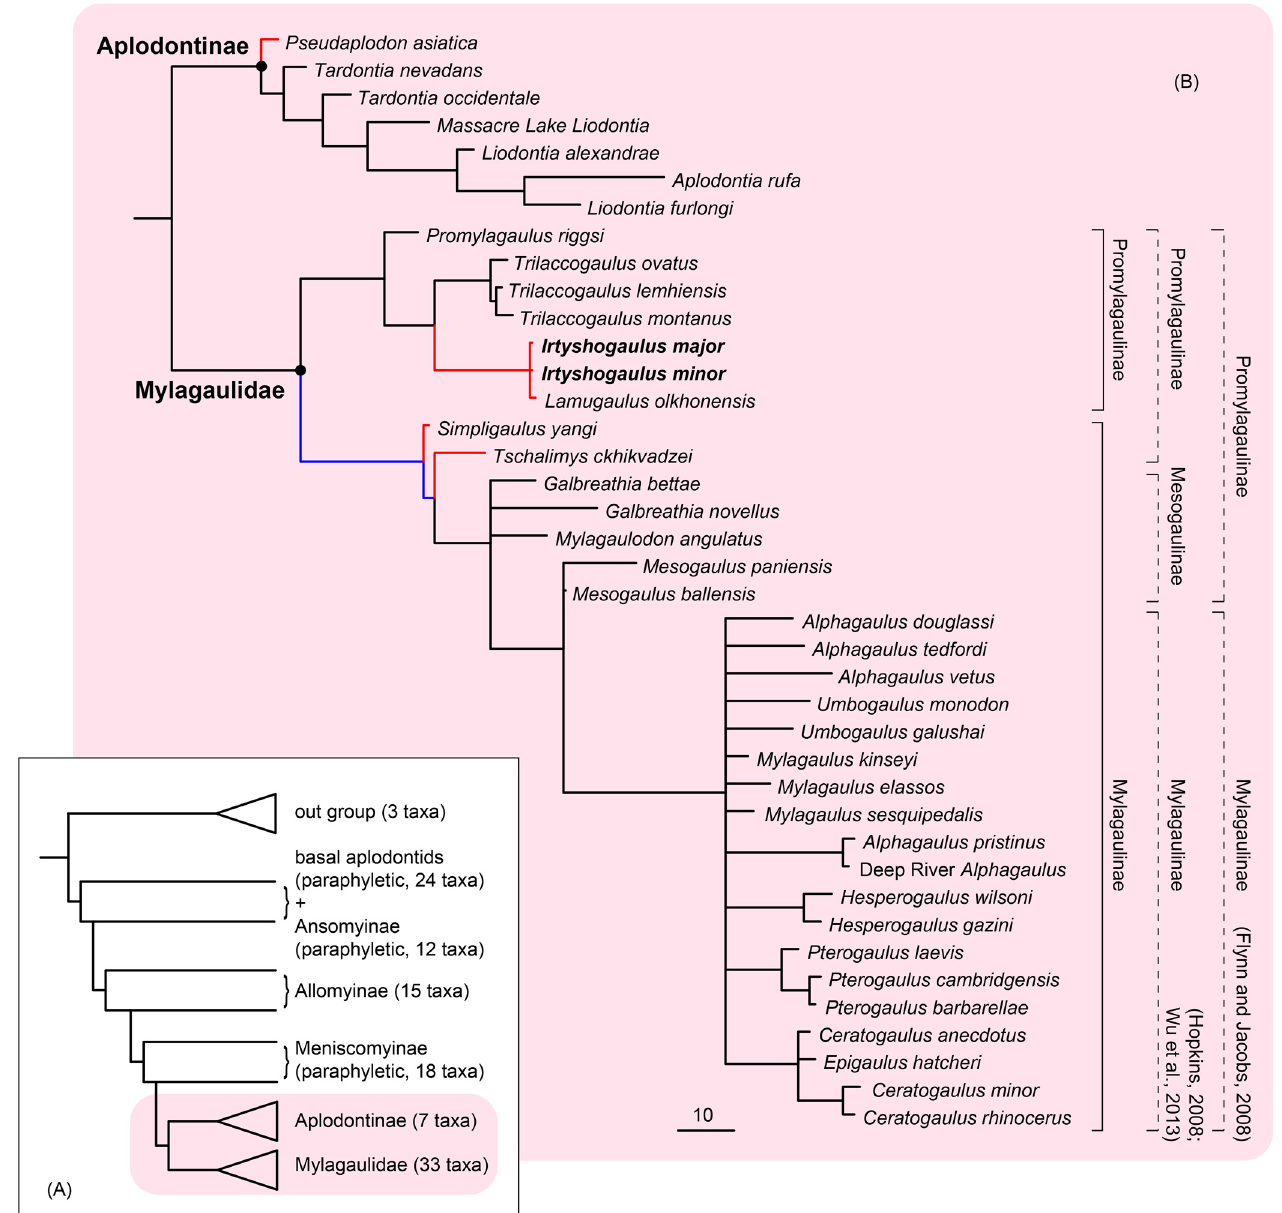
Fig 4. Phylogeny and distribution of mylagaulid and aplodontine rodents. Strict consensus is from 58 most-parsimonious trees. Each tree has a Best Score of 1585, a Consistency Index of 0.1684 and a Retention Index of 0.6659. (A), Summarized phylogeny of Aplodontoidea, showing the phylogenetic positions of Mylagaulidae and Aplodontinae; (B), Phylogeny of Mylagaulidae and Aplodontinae. Branch lengths indicate the number of character changes, but have no temporal meaning. The paleobiogeographic distribution of mylagaulids and aplodontines was reconstructed by using parsimony criterion in Mesquite v3.03: black for North America, red for Asia, and blue for equal parsimony. Dashed square brackets on the right show the previously published classifications, and solid line brackets show the classification scheme used in this